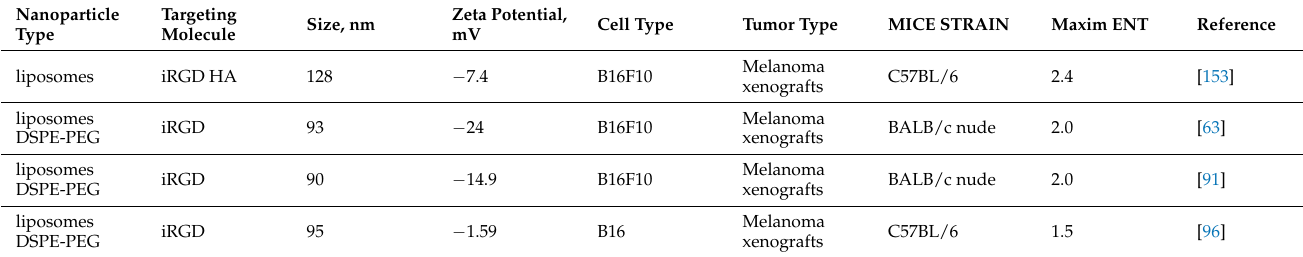
Table 4. Nanoparticles targeted by the iRGD peptide in the B16F10 and B16 melanomas. The data are sorted by the maximum ENT